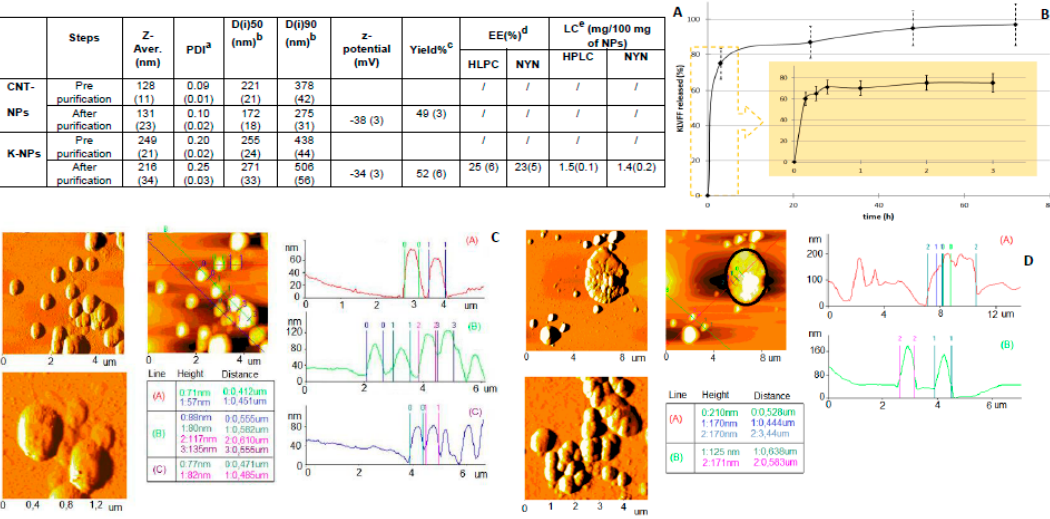
Figure 1. ( A ) Physico–chemical properties and technological characterization of samples. Values are mean ± SD (standard deviation) (n = 9) reported in brackets. ( B ) KLVFF release from NPs, ( C ) AFM analyses of CNT-NPs and ( D ) K-NPs. a polydispersity Index (PDI); b The results were expressed as intensity distribution (D(i)), i.e., the size below which is placed the 50% (D(i)50)) and 90% (D(i)90)) of all the particles; c the percentage of yield was expressed as the ratio of the recovered freeze-dried sample out of the total mass-weighted (polymer + drug) percent; d the percentage of encapsulation efficiency was expressed as the ratio of the encapsulated out of the total (encapsulated + free) drug percentage; e the drug content (loading capacity, LC) was expressed as the amount of the encapsulated drug in 100 mg of NPs.